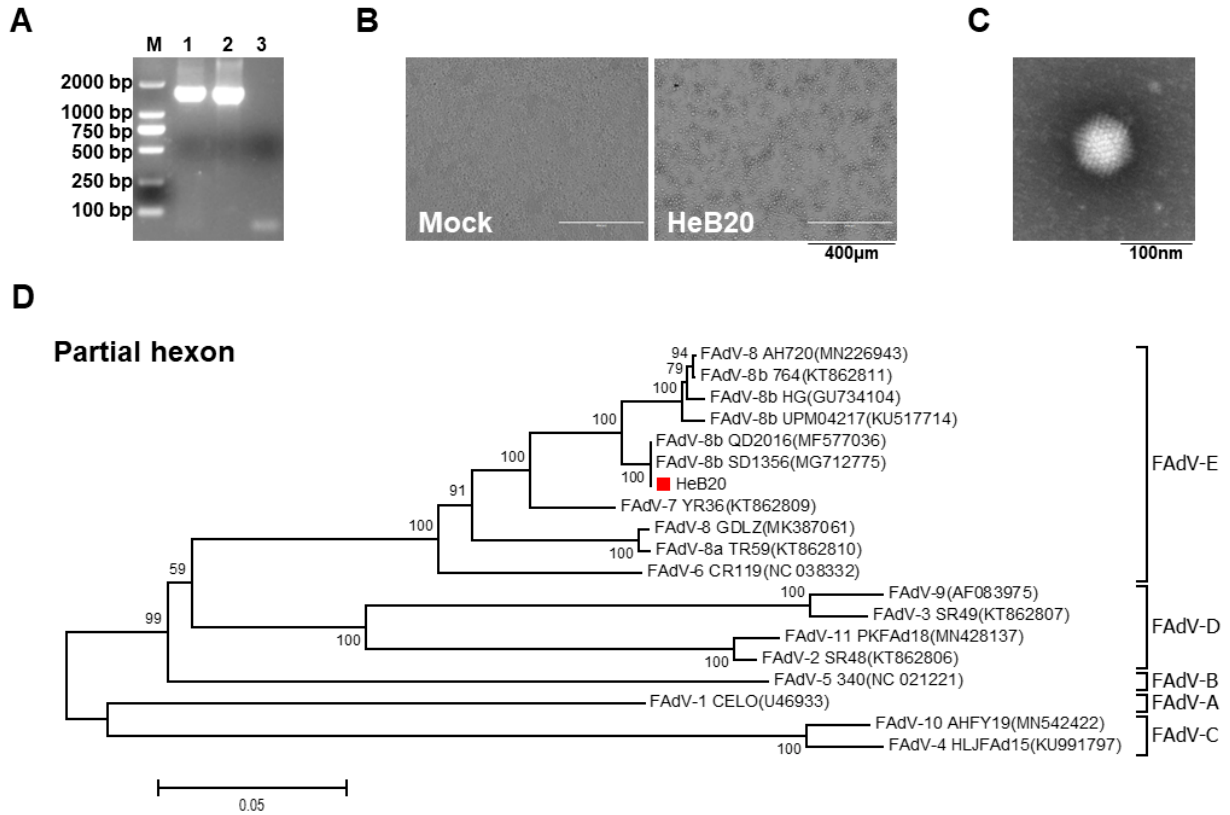
Figure 1. Characterization and purification of FAdV-8b strain HeB20. ( A ) PCR amplification of a 1655 bp region of the hexon gene. Line 1: PCR product of DNA template from clinical liver sample; Line 2: PCR product of DNA template from purified HeB20; Line 3: PCR product of DNA templated from mock LMH cells. ( B ) Typical cytopathic effect (CPE) of HeB20 infection in LMH cell cultures (arrow). Non-infected LMH cells showed no CPE. ( C ) Purified virus particles were obtained via CsCl 2 gradient centrifugation. Scale bar = 100 nm. ( D ) Phylogenetic analysis of FAdV-8b strain HeB20 based on a sequence of the hexon gene. Accession numbers of the published sequence of the L1 hexon gene are provided in the parentheses.